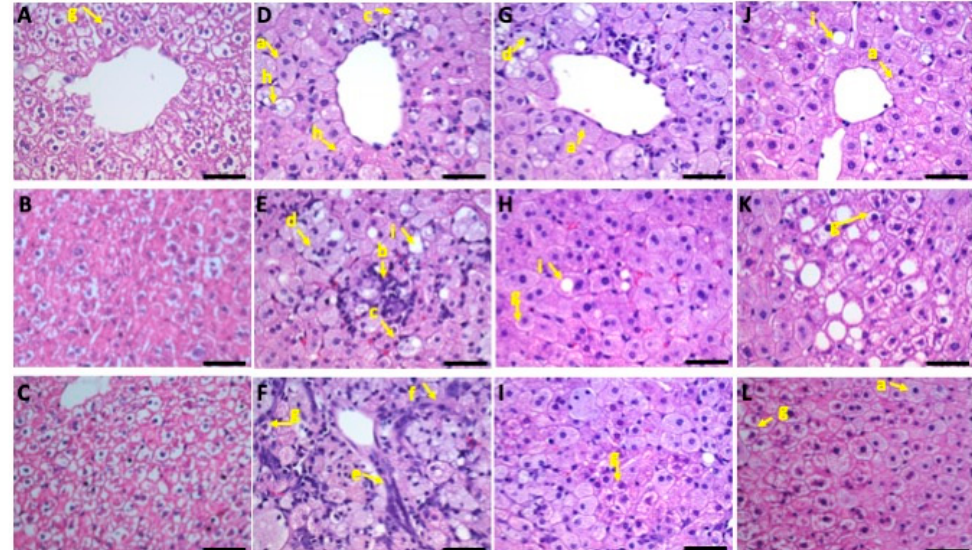
Figure 2. Control group ( A – C ): the liver showed no microvesicular or macrovesicular steatosis and no infiltration, however it showed severe / high glycogen accumulation (arrow g ). HC group ( D – F ): the liver presented severe / high microvesicular fatty change (arrow a ), moderate infiltration of mononuclear cells (arrow b ) and neutrophils (arrow c ), moderate Kup ff er cell hyperplasia (arrow d ), moderate oval cell hyperplasia (arrow e ), moderate fibrosis (arrow f ), slight glycogen accumulation (arrow g ), and minimal hepatocellular necrosis (arrow h ). Low-dose HC + HO group ( G – I ): the liver presented severe / high microvesicular fatty change (arrow a ), minimal macrovesicular fatty change (arrow i ), slight infiltration of mononuclear cells (arrow b ) and neutrophils (arrow c ), moderate Kup ff er cell hyperplasia (arrow d ), slight oval cell hyperplasia (arrow e ), slight fibrosis (arrow f ), minimal glycogen accumulation (arrow g ), and minimal hepatocellular necrosis (arrow h ). High-dose HC + HO group ( J – L ): the liver presented severe / high microvesicular fatty change (arrow a ), slight macrovesicular fatty change (arrow i ), slight infiltration of mononuclear cells (arrow b ) and neutrophils (arrow c ), slight Kup ff er cell hyperplasia (arrow d ), slight oval cell hyperplasia (arrow e ), slight fibrosis (arrow f ), slight glycogen accumulation (arrow g ), and minimal hepatocellular necrosis (arrow h ). Scale bars are 200 µ m for ( A , D , G , J ); and 50 µ m for ( B , C , E , F , H , I , K ) and ( E , H , L